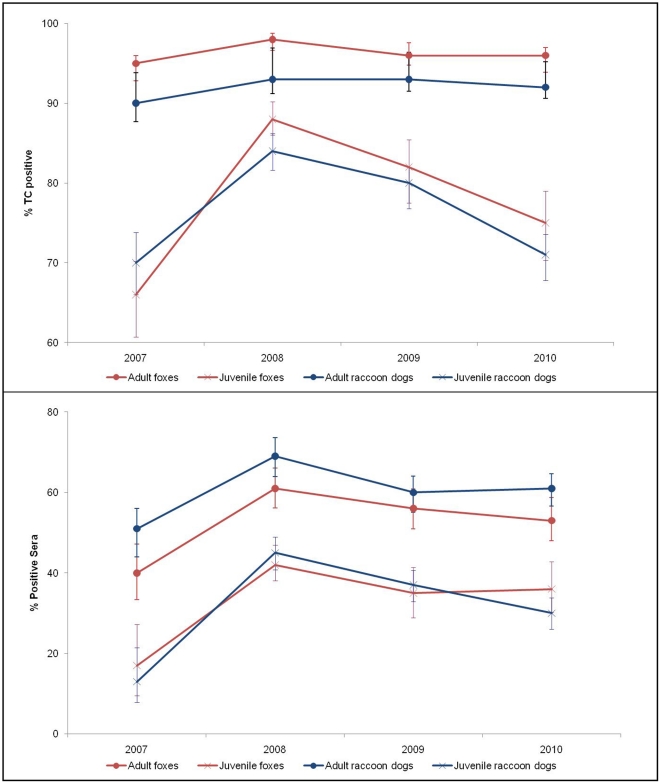
Tetracycline positivity and seroconversion in foxes and raccoon dogs (200–2010).The graphs are by age group (adult/juvenile).